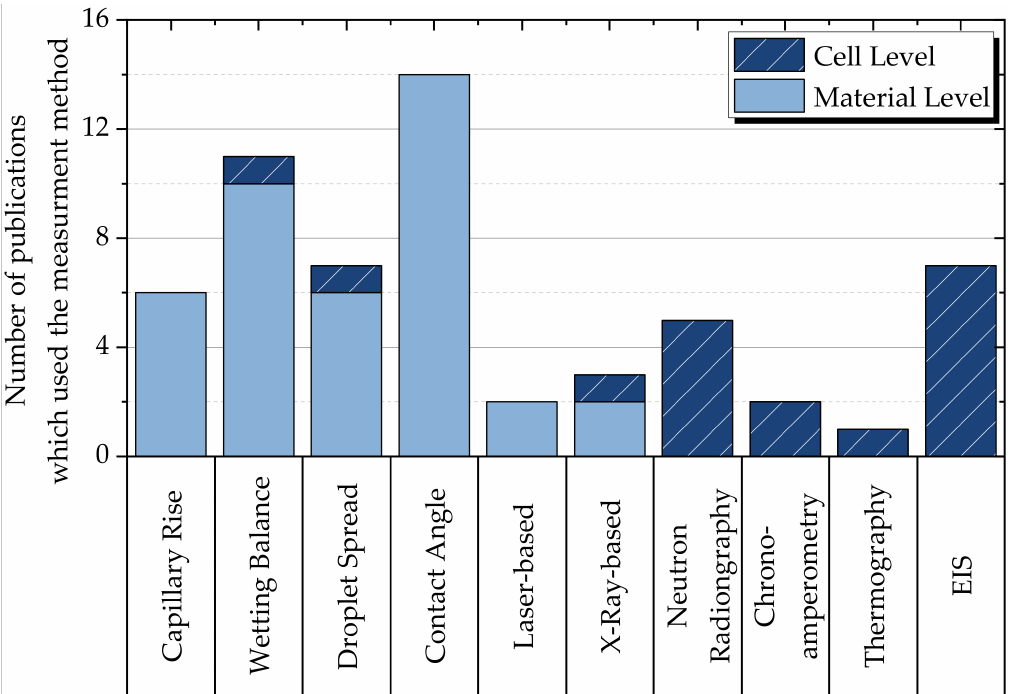
Figure 8. Illustration of the number of measurement methods used in the publications examined, with a classification of the measurements into material and cell